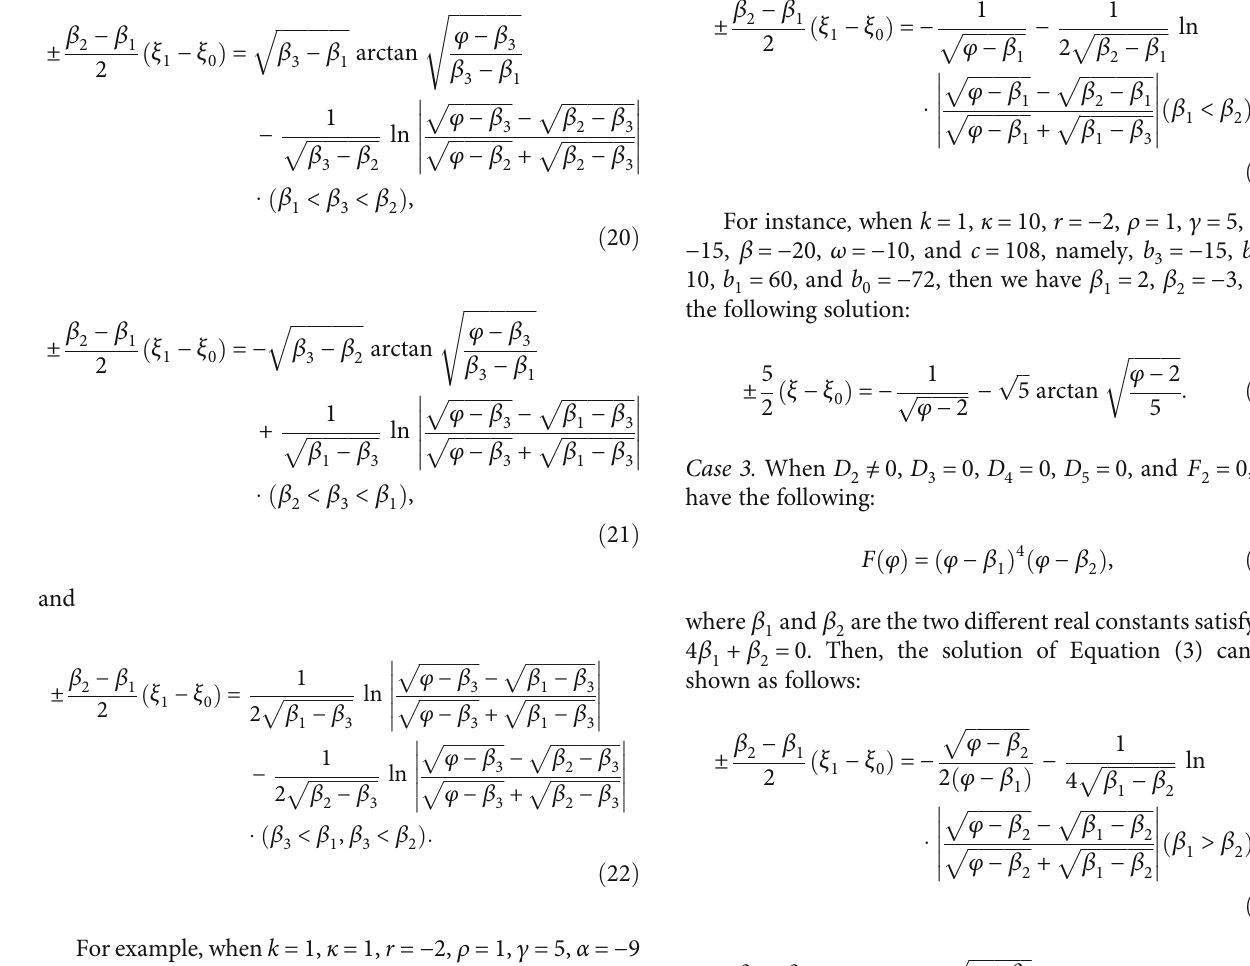
ffiffiffiffiffiffiffiffiffiffiffiffiffiffi ffiffiffiffiffiffiffiffiffiffiffiffiffi p ffiffiffiffiffiffiffiffiffiffiffiffiffiffi φ − β ffiffiffiffiffiffiffiffiffiffiffiffiffi ffiffiffiffiffiffiffiffiffiffiffiffiffiffi